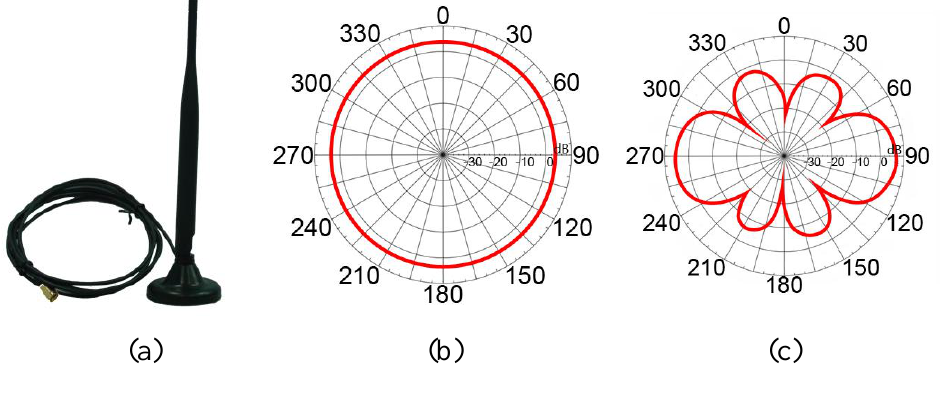
Figure 10. Specification of the omnidirectional antenna utilized in this study. (a) Maxim AN-05DW-S Antenna [46] that is connected to all sensor nodes used in this study, and the radiation patterns of the antenna in the (b) H-plane and (c)